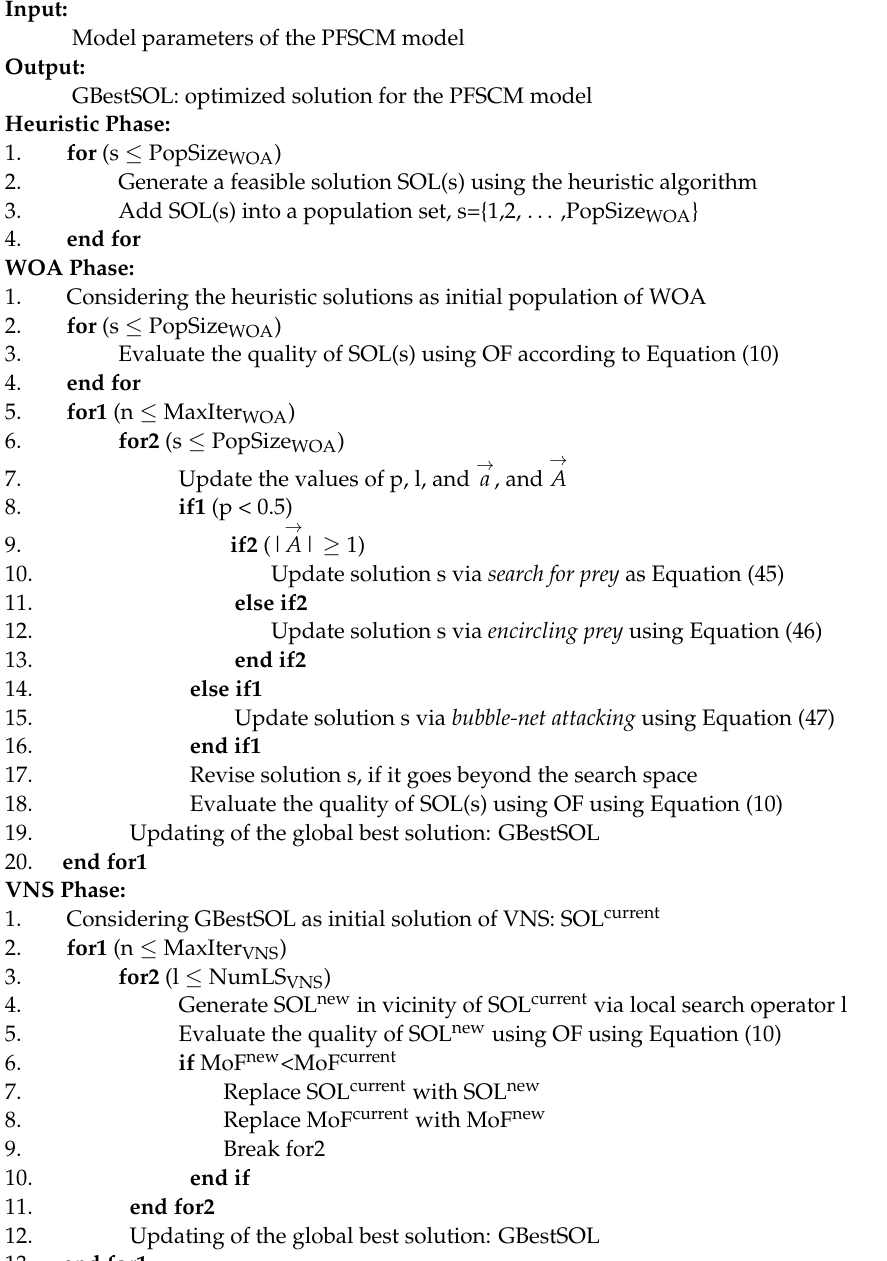
Algorithm 1. Proposed H-WOA-VNS algorithm for solving the PFSCM